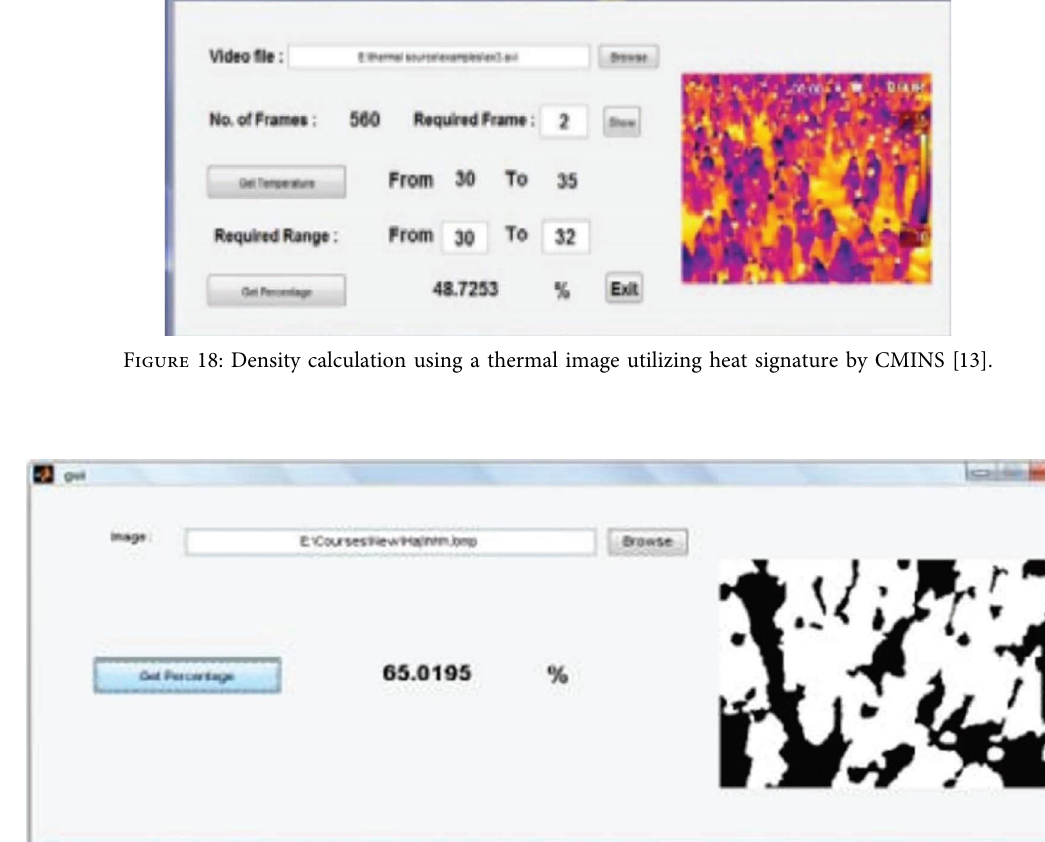
Figure 19: Density calculation using a thermal image utilizing background subtraction by Abu Arafah